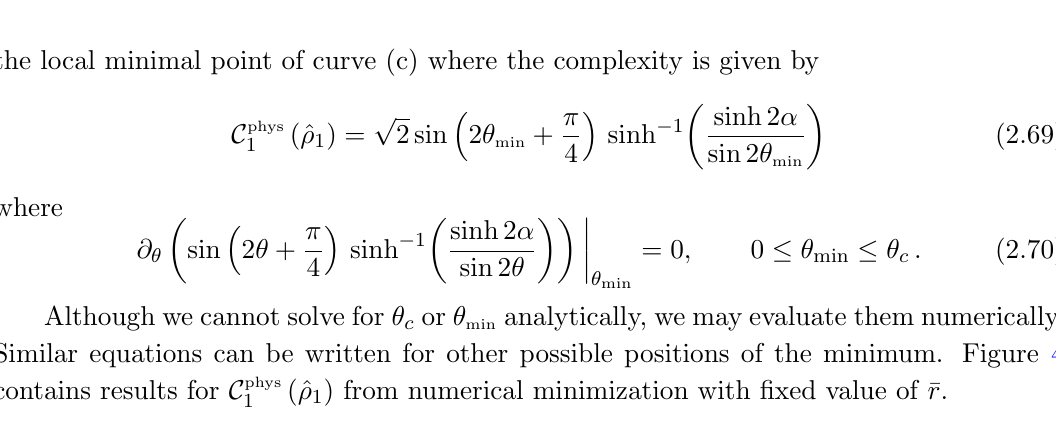
(^ (cid:26) 1 ) in eq. (2.68) ceases to be 1 ;c